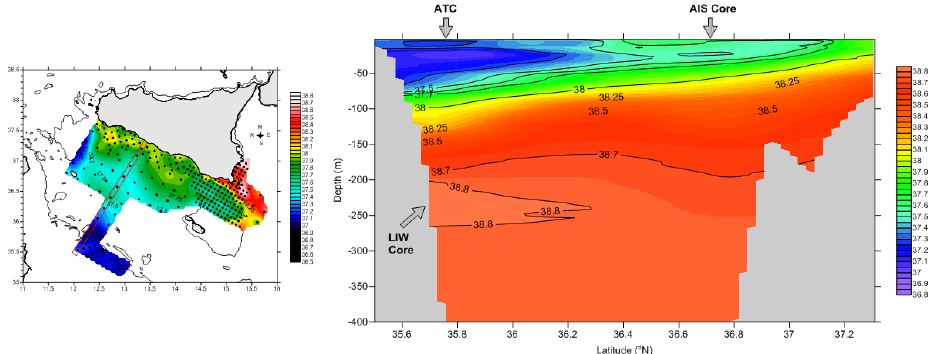
Figure 6. Surface-salinity map, estimated in the oceanographic survey “Ansic 03” (left side). Salinity section (right side) and position of the main water masses along the selected transect (red box on the map) 250km long